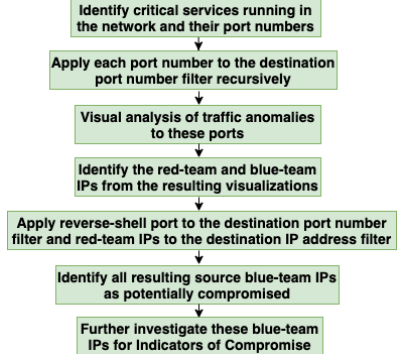
Figure 7. A simple forensic study